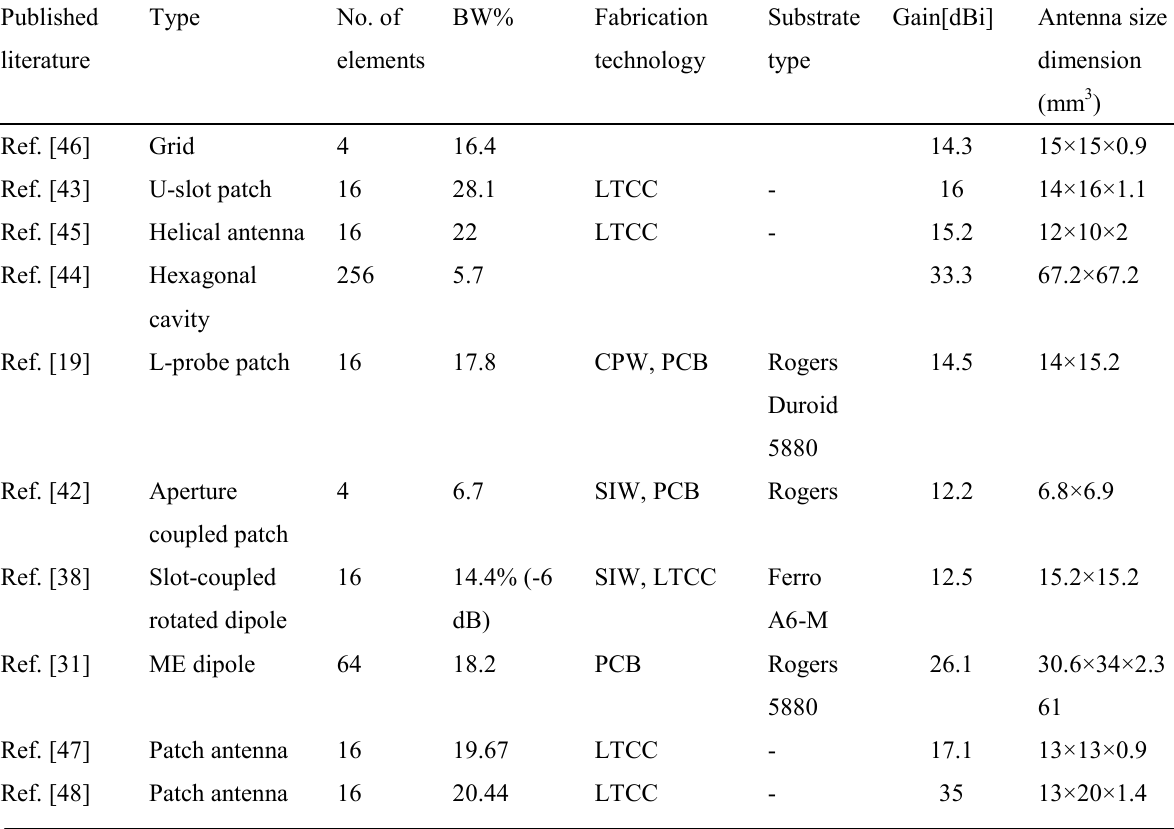
Table 3: Circular polarization for 60 GHz